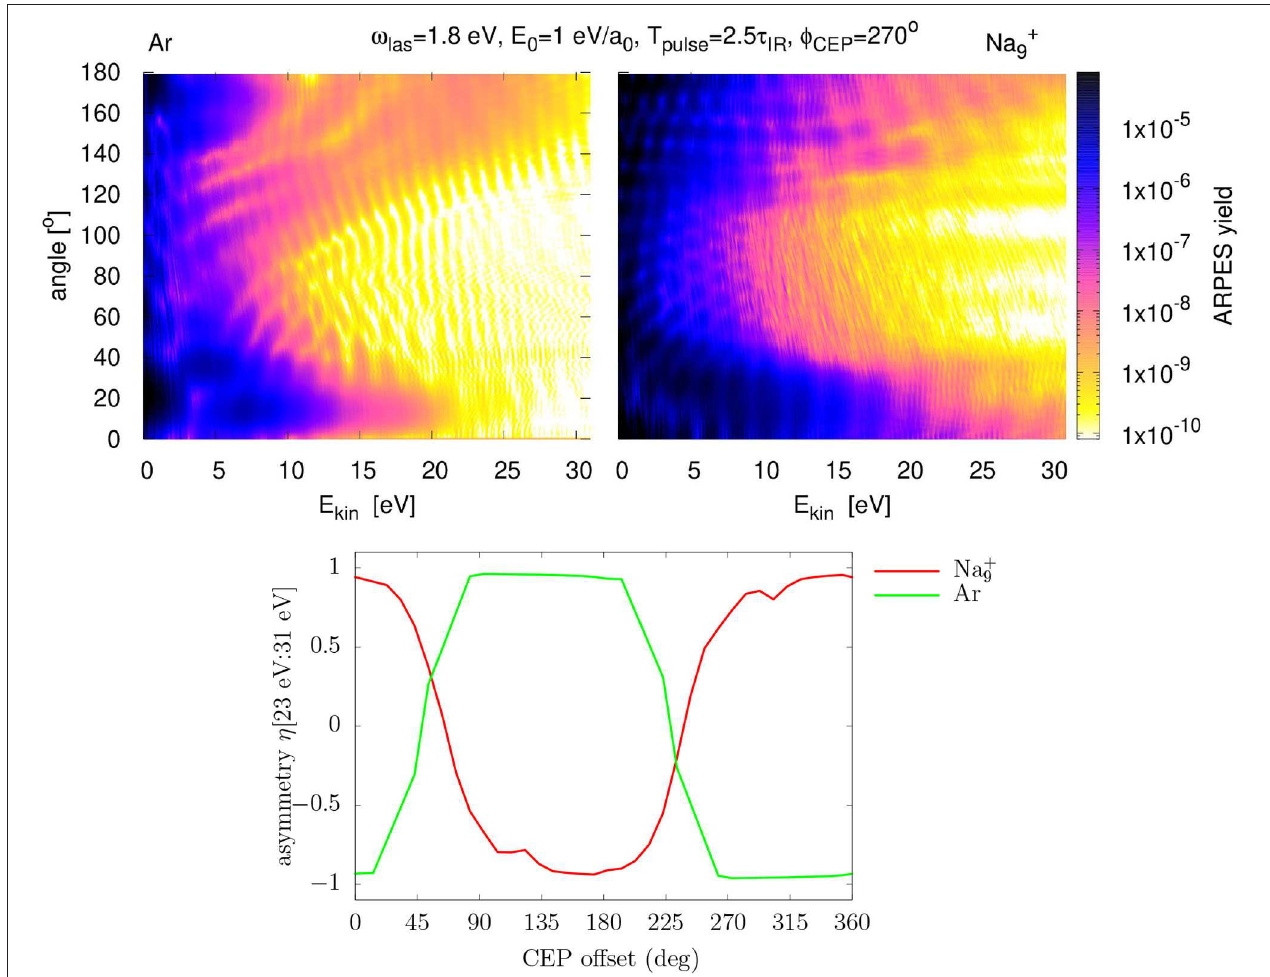
FIGURE 3 | Ar atom and Na + 9 cluster excited by a laser with ω las = 1.8 eV, I = 6 × 10 13 W/cm 2 , pulse length T pulse = 6 fs (corresponding to 2.5 optical cycles), and φ CEP = 270 ◦ . Upper panels: ARPES yield Y in the plane of kinetic energy E kin and emission angle θ , for Ar (left) and Na + 9 (right). Lower panel: asymmetry parameter η ( E kin ) integrated on the E kin interval [23eV :